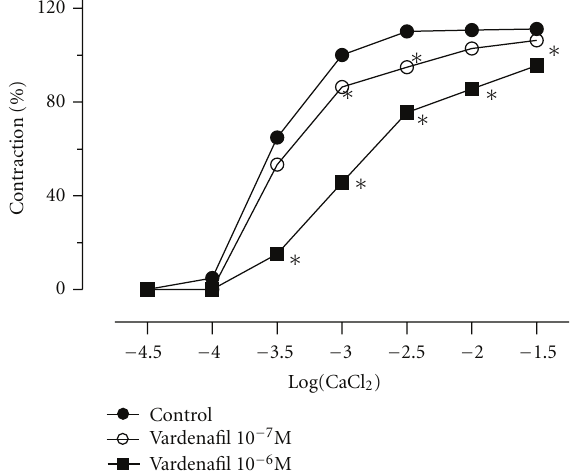
Figure 4: Concentration-response curves to CaCl 2 in the absence or presence of vardenafil (10 − 7 –10 − 6 M; n = 13) in pulmonary hypertensive rat pulmonary artery rings. Data were calculated relative to the maximal changes from the contraction produced by KCl (80mM) in each ring, taken as 100%. ∗ P < 0 . 05 as compared with